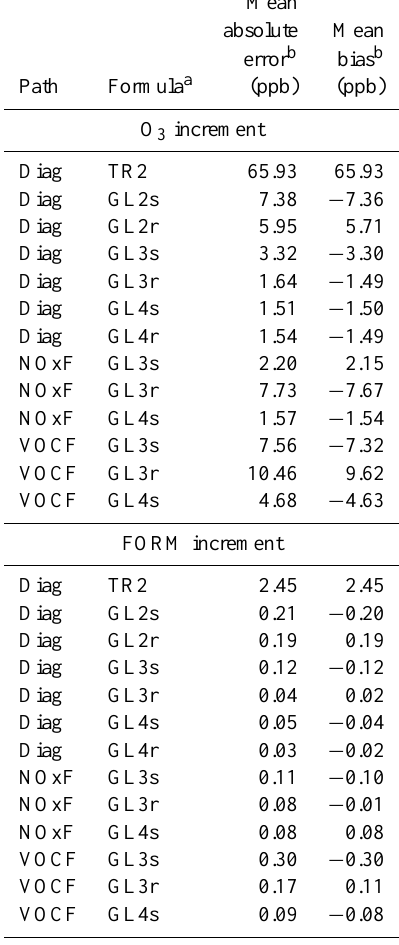
a TR2 = trapezoidal rule, two points. GLnx = Gauss–Legendre formula using n points and x as the integration variable. b Hourly average over the 3-day